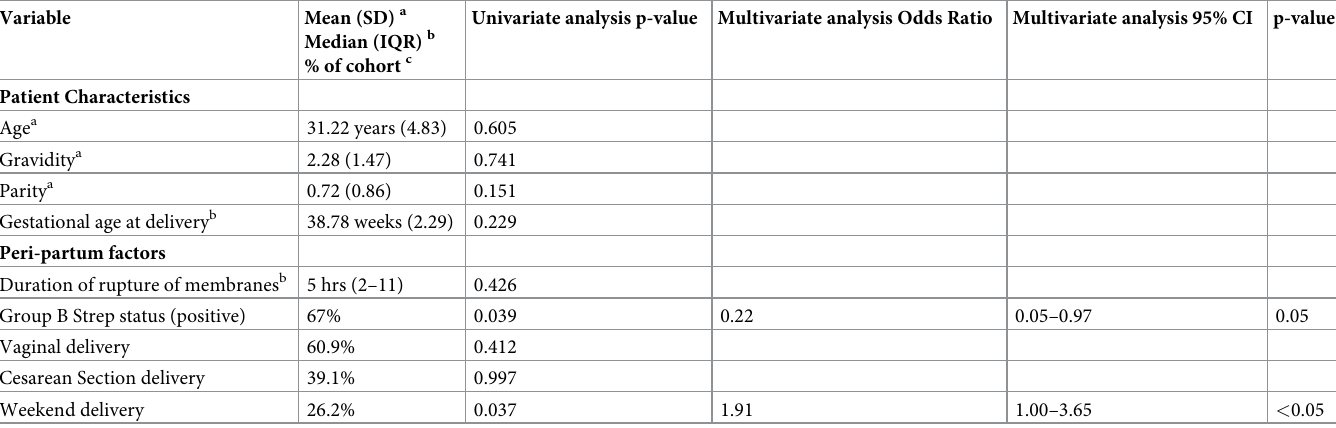
Table 1. Baseline patient characteristics of patients and predictors of admission.